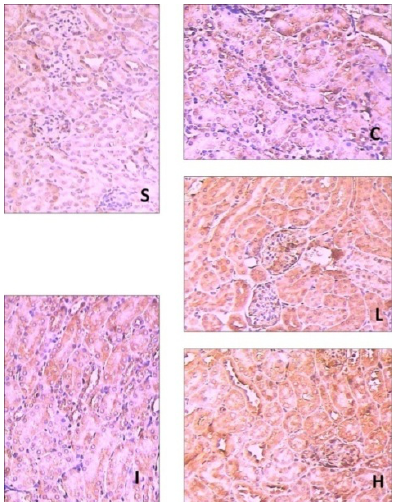
Figure 4. The expression of HO-1 in the renal tissues in the groups by immunohistochemmistry (SP × 200). S: Sham group; I: IIR group; C: NS group; L: RB1-30 group; H: RB1-60